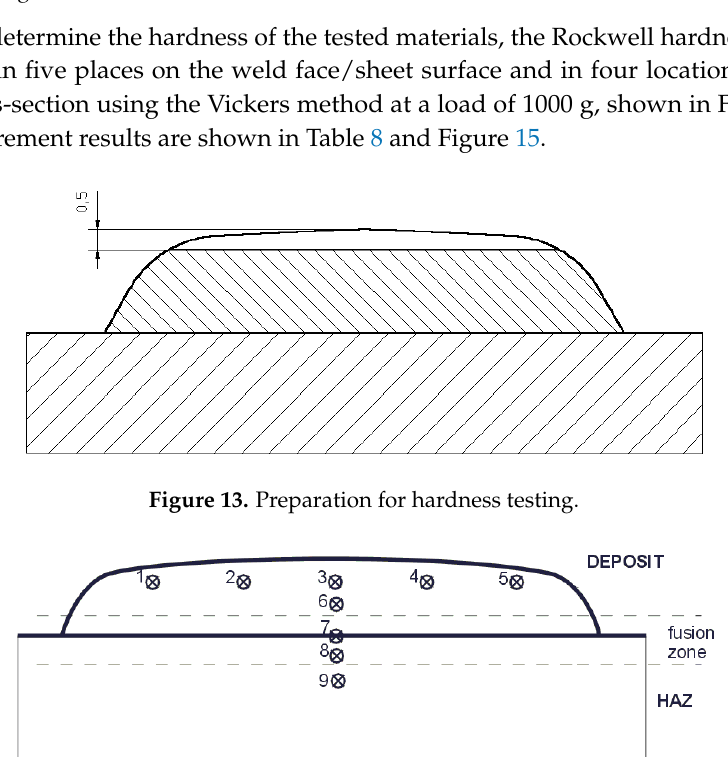
Figure 12. The diffraction pattern of the nanocrystalline Fe-Cr-Nb-B layer.